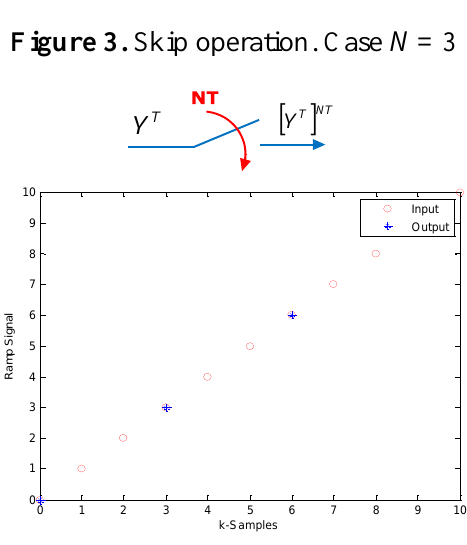
Figure 3. Skip operation. Case N =